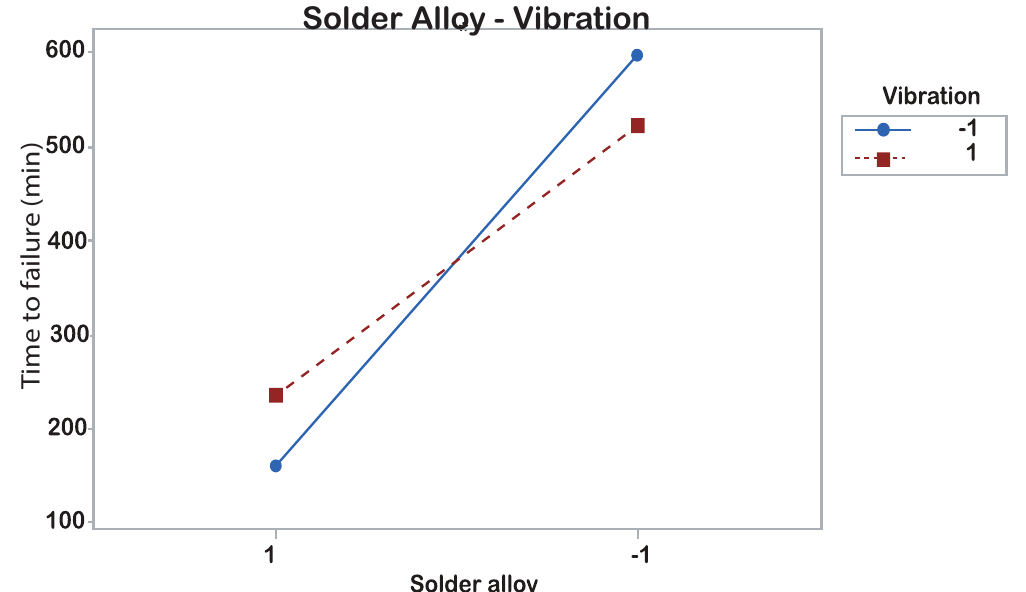
Figure 5. Interaction graphic for time to failure. Corresponds to the SnPB alloy.